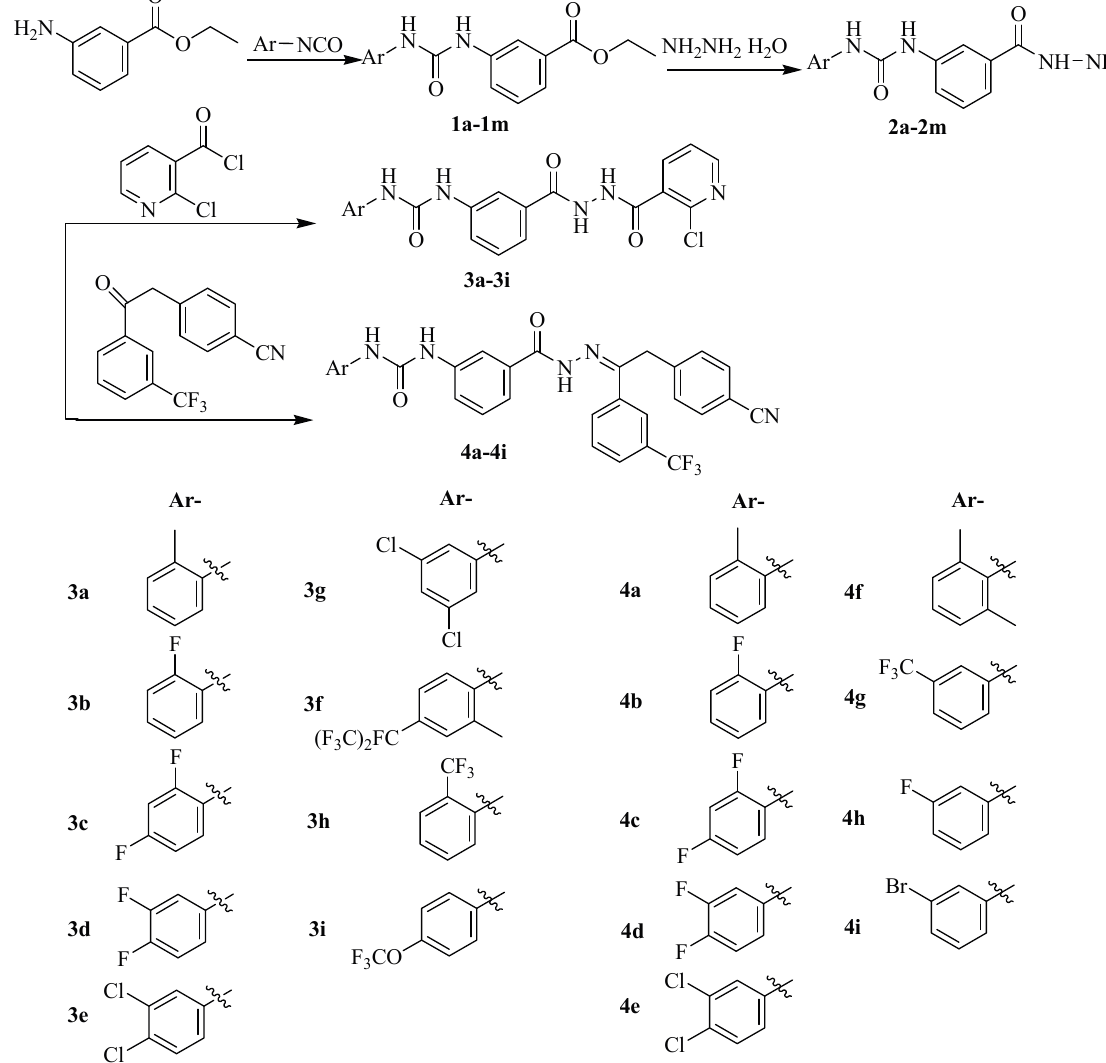
Scheme 1. Synthesis of phenylurea